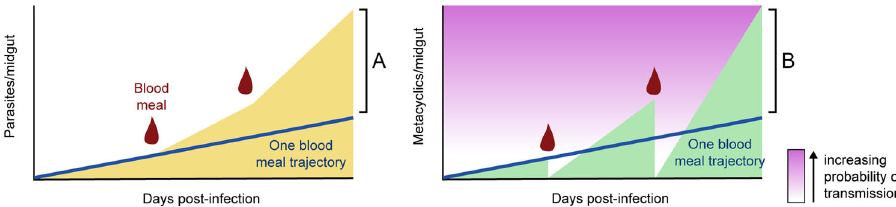
Fig. 4 The impact of multiple blood-meals on the maturation of Leishmania infections within the sand fl y vector. In nature, sand fl ies are expected to feed on blood multiple times for the completion of more than one gonotrophic cycle. Importantly, the intake of multiple bloodmeals (represented by the red blood drops) is expected to impact the vector competence, promoting not only the increase in the absolute parasite numbers (yellow) but also in both the percentage and number of the metacyclic infectious forms (green) in the sand fl y midgut. Importantly, such an increase in total parasite numbers ( A ), and particularly in the number of metacyclic promastigotes ( B ) in the midgut of infected sand fl ies that take subsequent blood meals, compared with single-fed fl ies (blue lines), results in a higher probability of transmission of Leishmania parasites (purple gradient). Courtesy